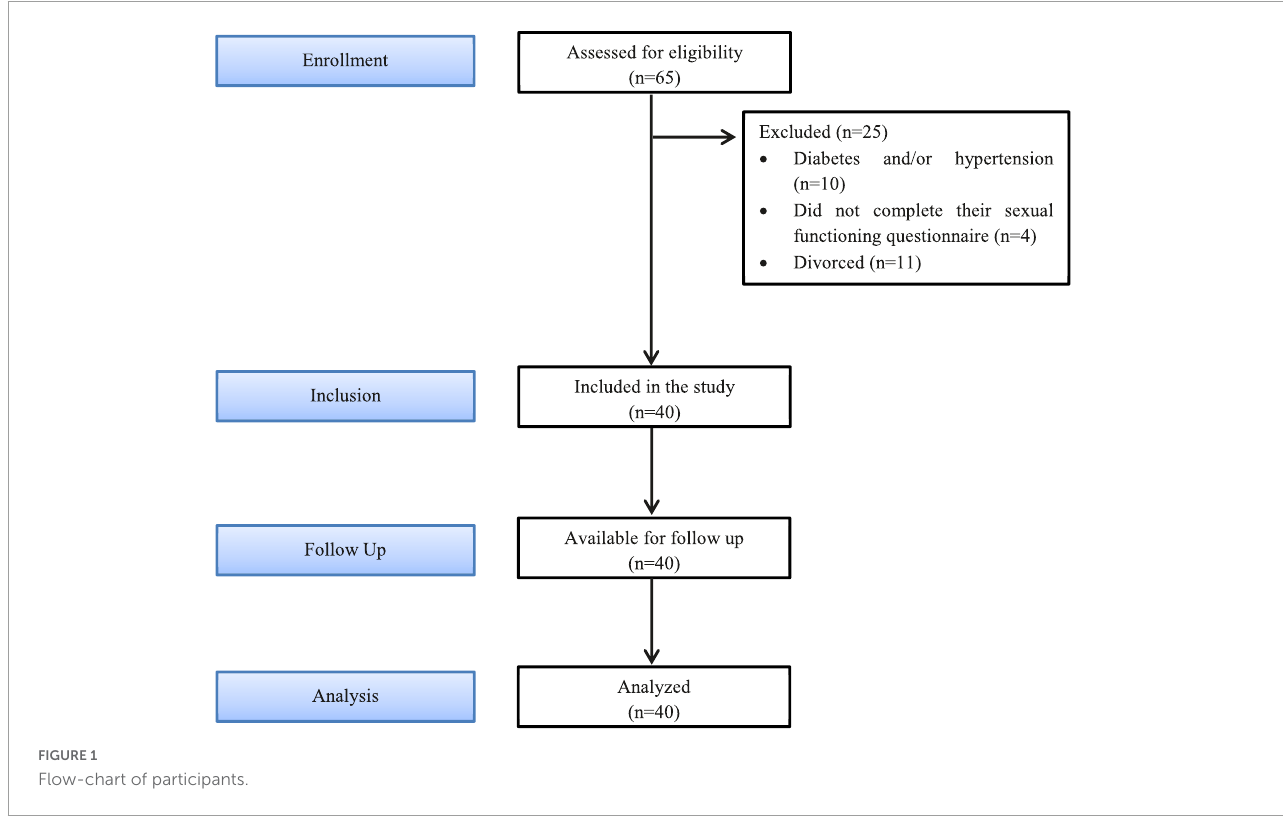
FIGURE1 Flow-chart of participants.